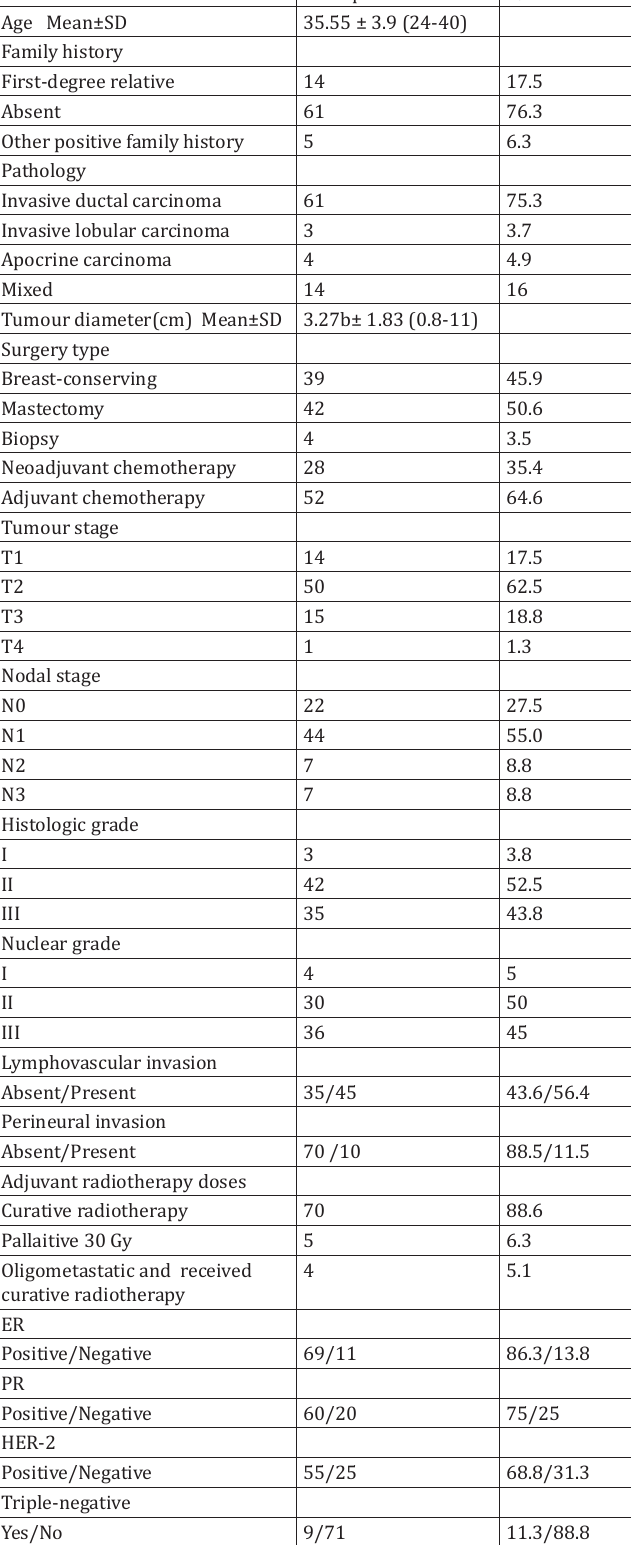
Characteristics of patients and treatment features